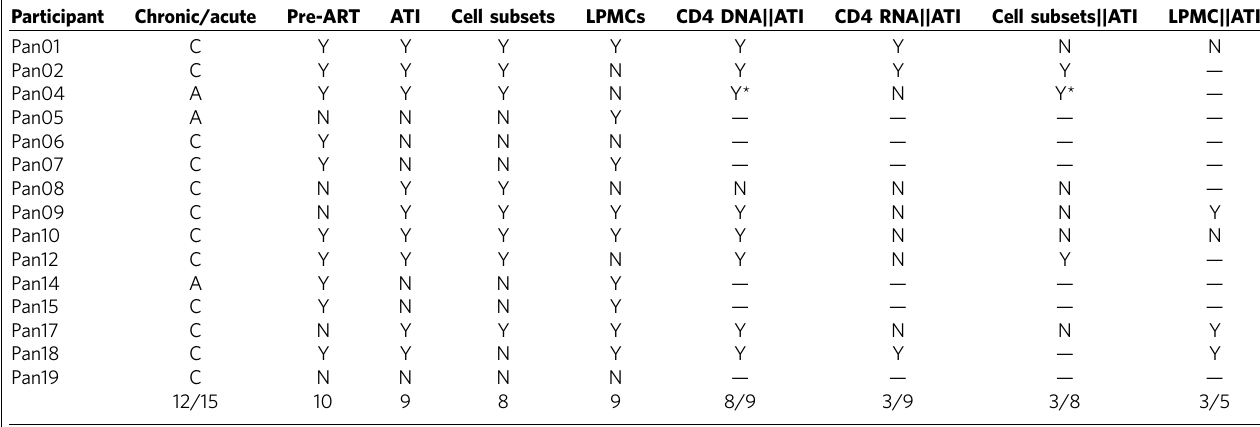
Table 2 | Samples collected and similarity analysis summary for each participant.